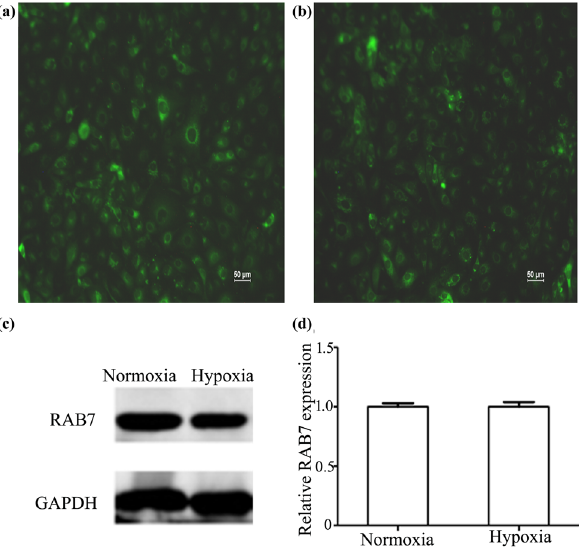
Figure 3: Expression of RAB7 protein in HK - 2 cells with GFP - RAB7 lentiviral vector under hypoxia or normoxia. ( a ) Expression of RAB7 protein in HK - 2 cells with GFP - RAB7 lentiviral vector under nor - moxia. ( b ) Expression of RAB7 protein in HK - 2 cells with GFP - RAB7 lentiviral vector under hypoxia. The results show no di ff erence. ( c ) Expression of RAB7 protein in HK - 2 cells with GFP - RAB7 lentiviral vector under hypoxia and normoxia was detected by western